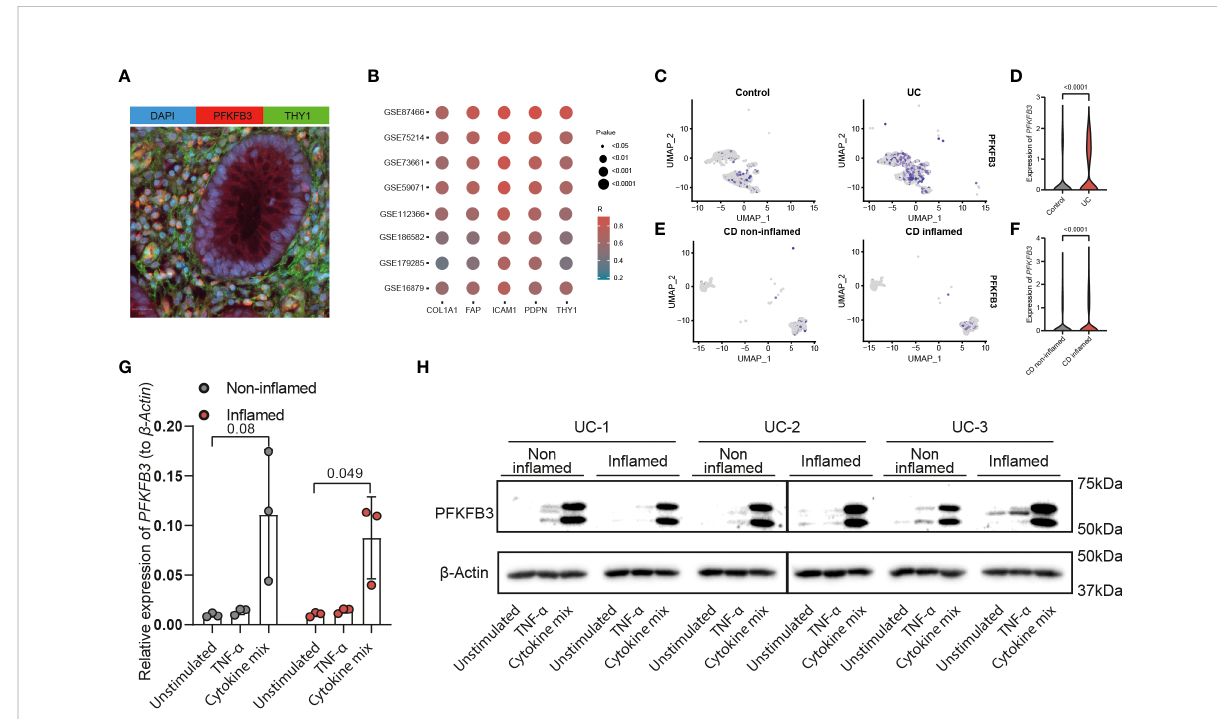
FIGURE 2 PFKFB3 expression was associated with stromal marker gene expression and elevated in fi broblasts in an in fl ammatory environment. (A) Immuno fl uorescent staining of PFKFB3 and the fi broblast marker THY1 in IBD tissue (PFKFB in red; THY1 in green; DAPI in blue (nuclei). Scale bar is 20 m m. (B) Spearman ’ s correlation of PFKFB3 expression and stromal genes ( COL1A1 , FAP , ICAM1 , PDPN , and THY1 ) expression in 8 online datasets. Colors represent the level of correlation, dot size indicates the p value. UMAP plot of stromal cells in datasets GSE114374 (C)